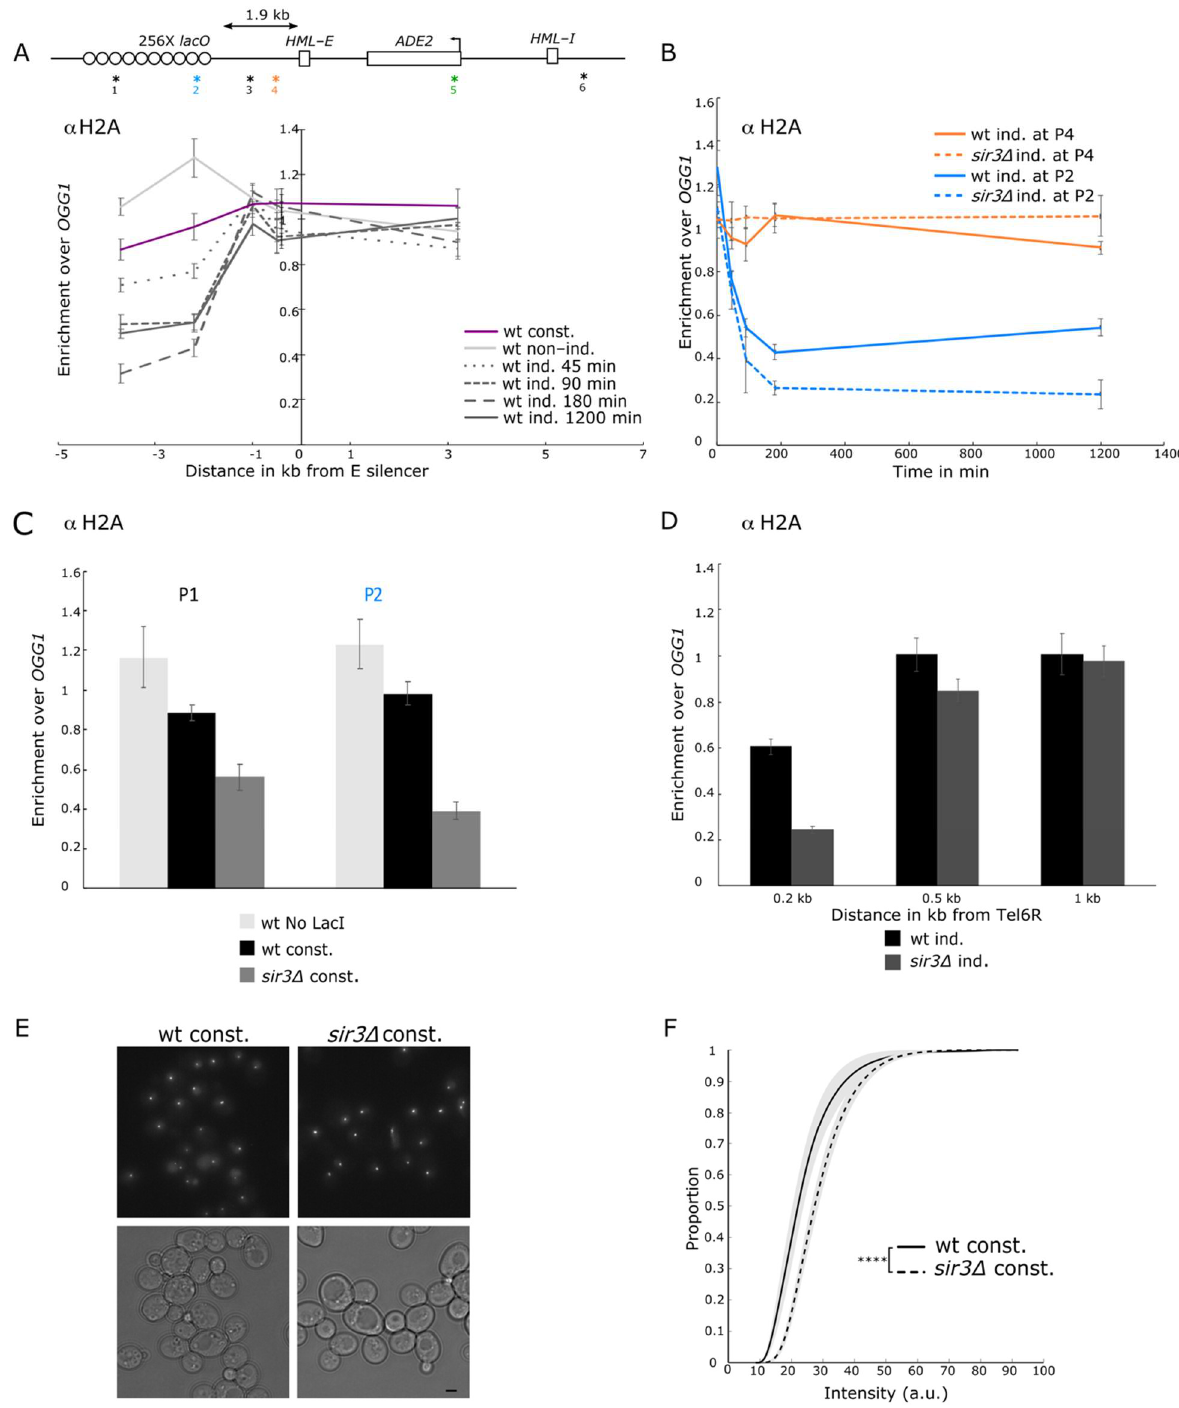
Figure 6. Sir3 spreading counteracted LacI-induced nucleosome eviction. ( A ) H2A occupancy along the of lys2::lacO E-ADE2-I locus probed by ChIP-qPCR using an anti-H2A antibody in strains expressing either the GFP-LacIR under the constitutive HIS3 promoter (wt const., yAT2059) or under the GALS promoter (wt ind., yAT2078) in raffinose (no induction), or after 45 min, 90 min, 180 min, and 1200 min of galactose induction. (P1), (P2), (P3) (P4) amplicons are respectively located at 3.7 kb, 2.2 kb, 1 kb, and 0.5 kb from the left side of the E silencer, and (P5) and (P6) amplicons are located at 3.2 kb and 6 kb from the right side of the E silencer, amplicon positions are localized with an asterisk and their respective number on the scheme of the locus The data were normalized over OGG1 (shown as mean ± s.e.m.; see Table S3 for the number of experiments). ( B ) H2A enrichment over time at the lacO (P2), and nearby the E silencer (P4), in a strain bearing the lys2::lacO E-ADE2-I locus, probed by ChIP-qPCR using an anti-H2A antibody in strains expressing the GFP-LacIR under the inducible GALS promoter in the WT (wt ind., yAT2078) and in a sir3∆ ( sir3∆ ind., yAT2370) strain, in raffinose